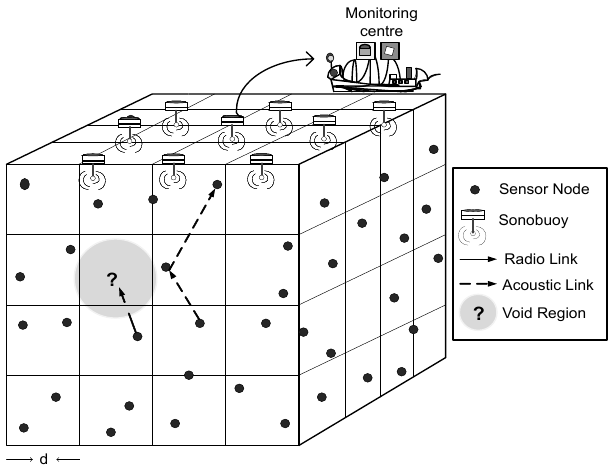
Figure 2. Network